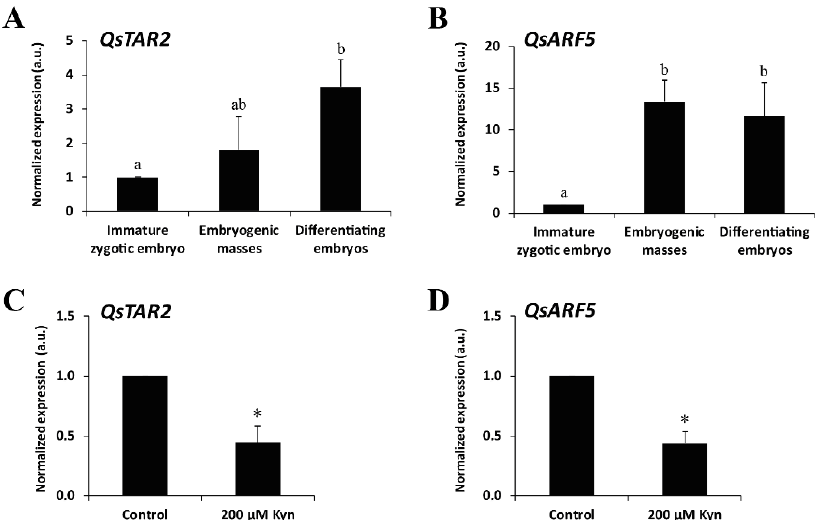
Figure 7. Gene expression pa tt erns of auxin biosynthesis QsTAR2 and auxin signaling QsARF5 genes by RT-qPCR, during somatic embryogenesis ( A , B ) and in control and kynurenine-treated proem- bryogenic masses after 21 days ( C , D ). Each column represents the mean of at least three biological and three technical replicates. Transcript levels were normalized to QsACTIN . Data were expressed as mean values of relative expression to immature zygotic embryos in ( A , B ) and to control cultures in ( C , D ); bars represent the standard error of the mean. Di ff erent le tt ers and asterisks in columns indicate signi fi cant di ff erences according to ANOVA and Tukey’s test at p ≤ 0.05.